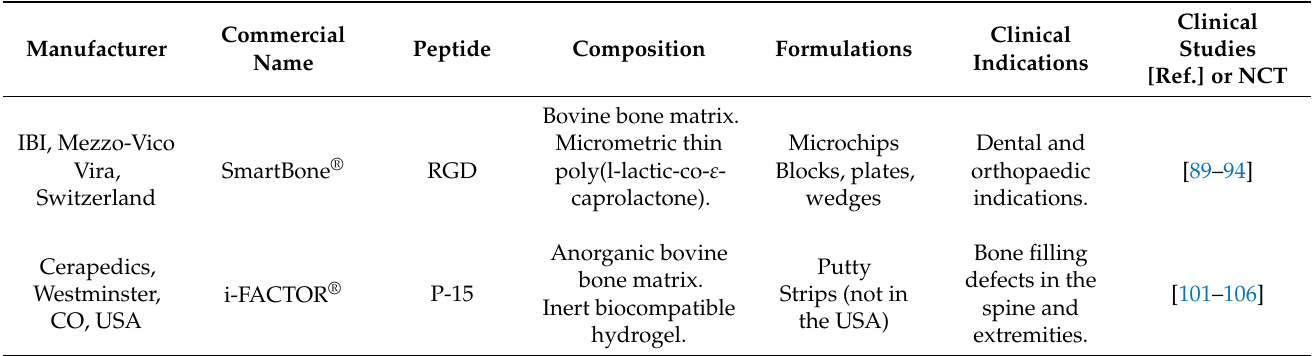
Table 3. Summary of peptide enhanced xeno-hybrid bone grafts commercially available for